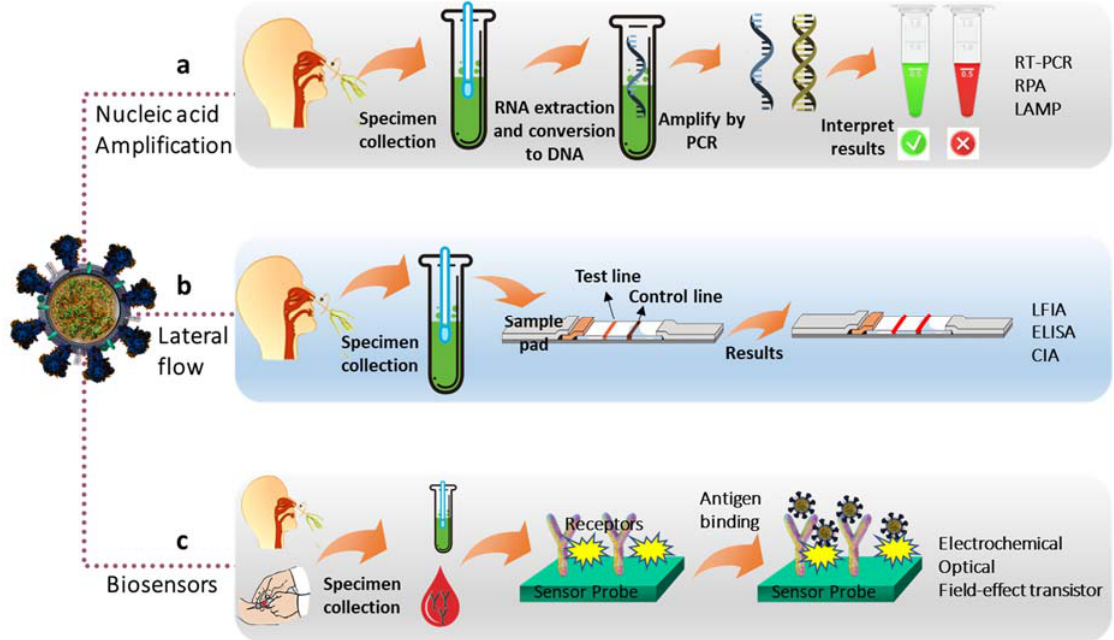
Figure 1. Schematic of the diagnosis methods of COVID-19. ( a ) Molecular testing based on nucleic acid amplification assays, ( b ) lateral flow immunoassay, and ( c ) biosensors.